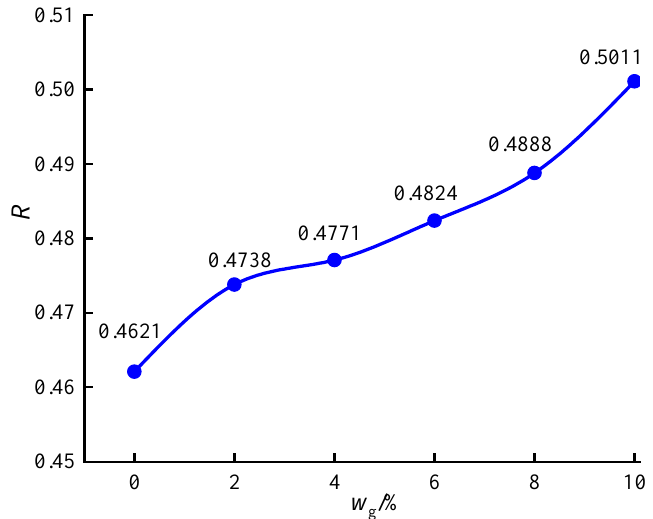
Figure 18. Roundness of solidified waste silt microscopic particles.